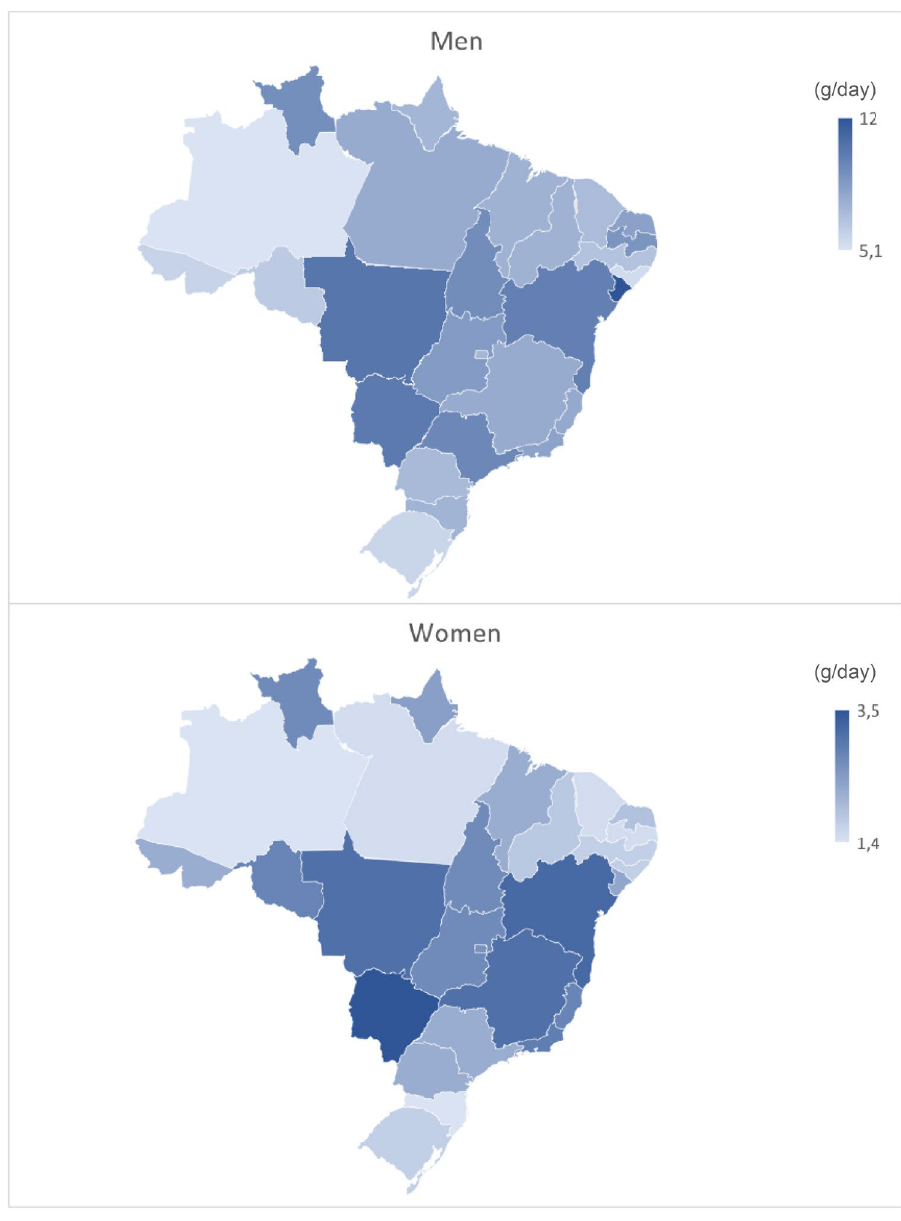
Figure 2. Average alcohol consumption (grams per day) by Brazilian adults in 2019 by state, by sex. These figures present the average consumption of alcohol in grams per day (g/day) by Brazilian states and Federal District, by sex. The maps of Brazil show the states in shades of blue according to the average consumption of alcohol for men and women. To the right of the maps are the blue scales corresponding to consumption: the darker, the higher the average